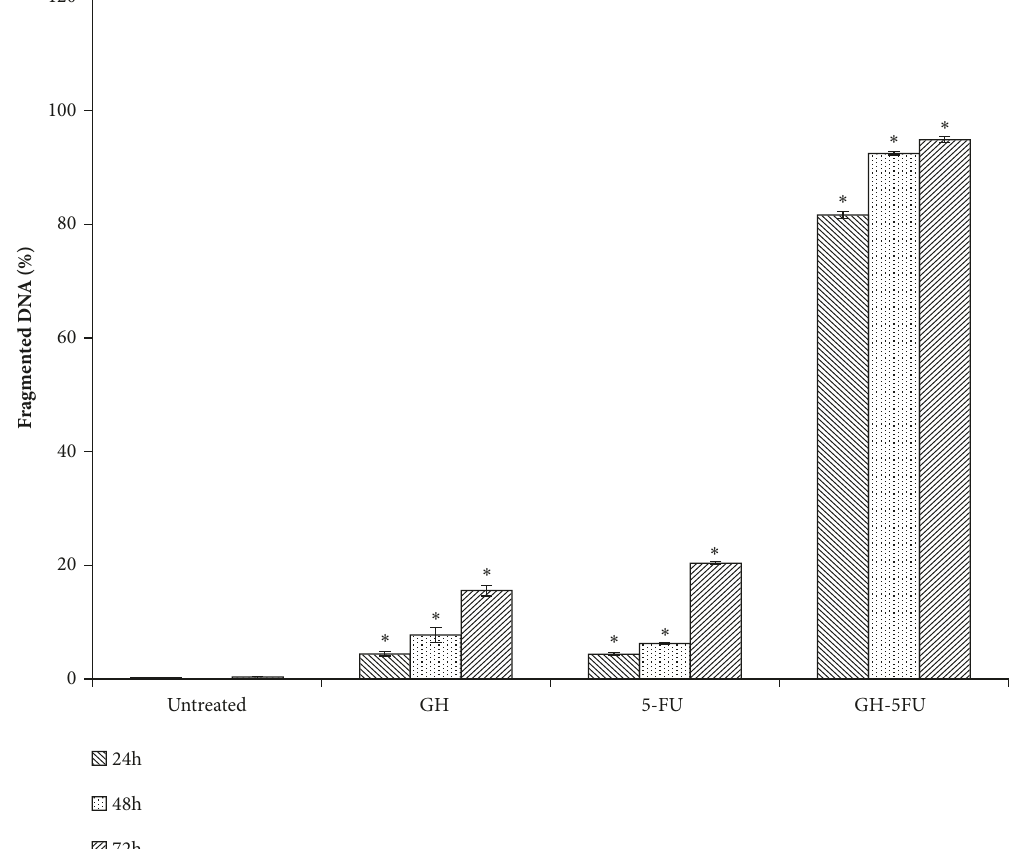
Figure 8: DNA fragmentation of HT-29 cells after treatmentwith GH, 5-FU, and both. Results are expressed as percentagesof cells stained by terminal dUTP nick-end labelling (TUNEL positive). Error bars represent means ± S.E.M. of the three independent experiments. ∗ Statistical significance (P < 0.05) between control cells and treatment